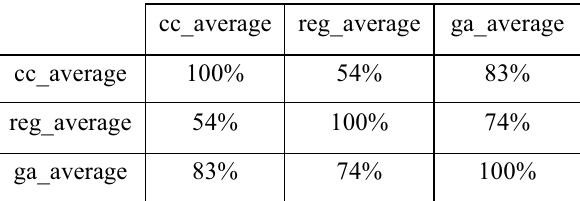
Table 2 . Correlation between features and target